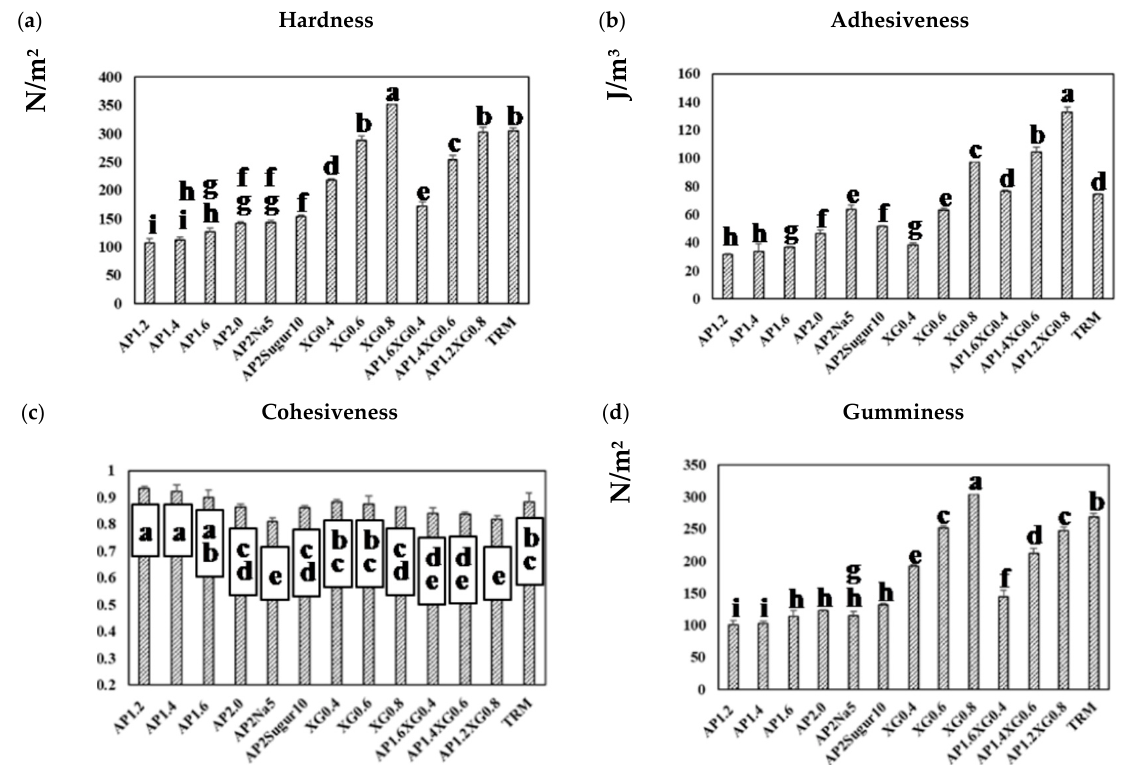
Figure 8. Texture profile analysis (TPA) on a series of model hydrocolloids: ( a ) hardness, ( b ) adhesiveness, ( c ) cohesiveness, and ( d ) gumminess. Error bars represent the standard deviations based on nine replicates. The lowercase letters indicate significant difference ( p < 0.05) of the referred textural properties; the x-legends represent the data of sole AP matrices, sodium or sugar contained AP matrices and composite AP-XG matrices, and the matrix prepared by a commercialized product, namely Neo-high Toromeal III ® , as control.